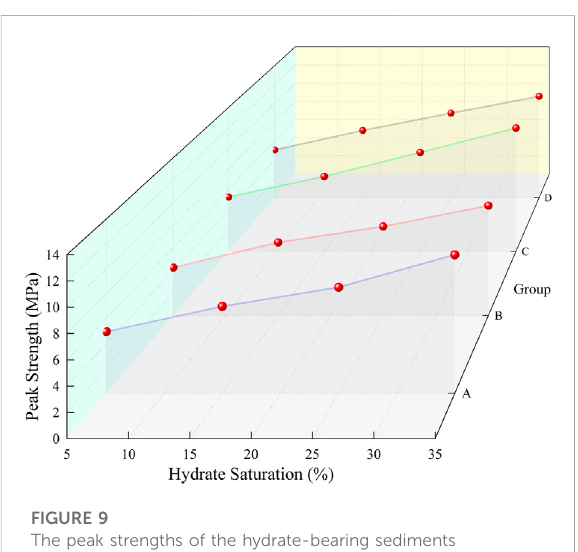
FIGURE 9 The peak strengths of the hydrate-bearing sediments increase with the increase of hydrate